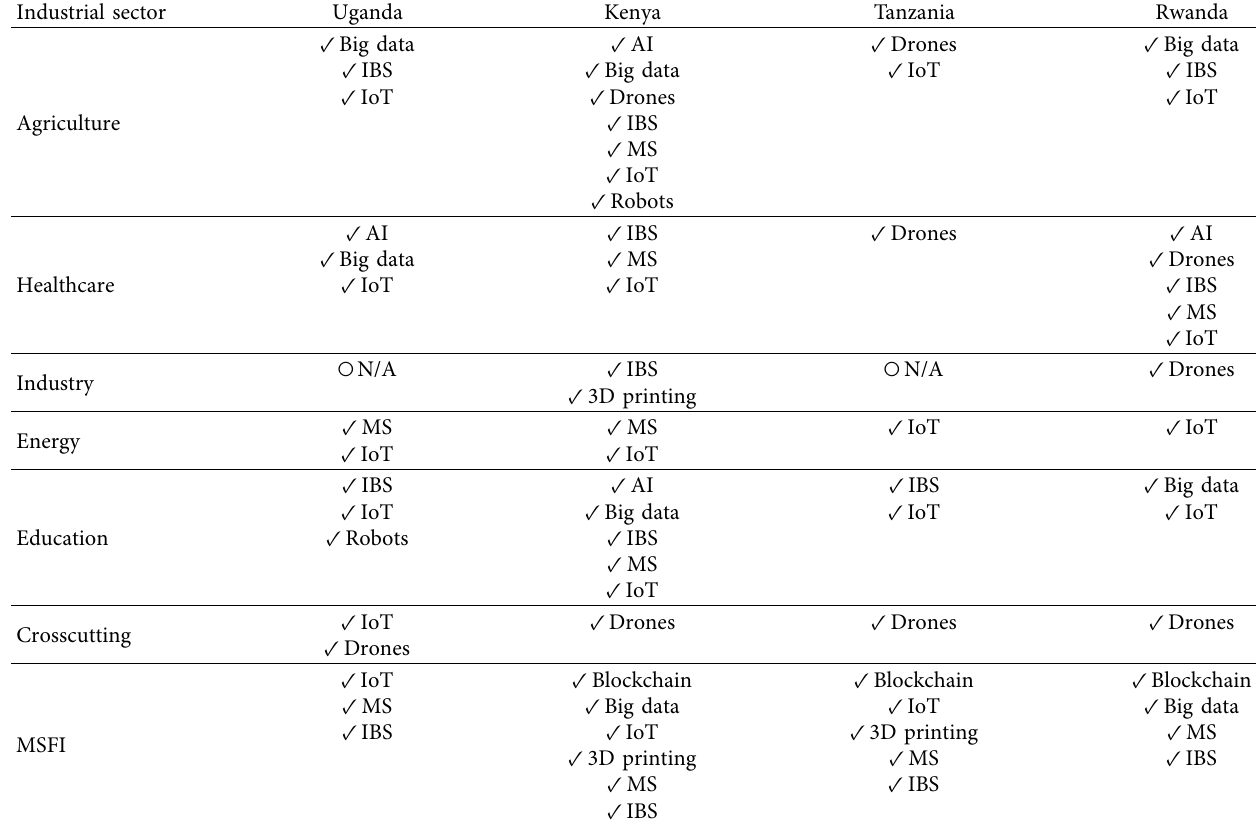
Table 12: Application of industry 4.0 technologies in industrial